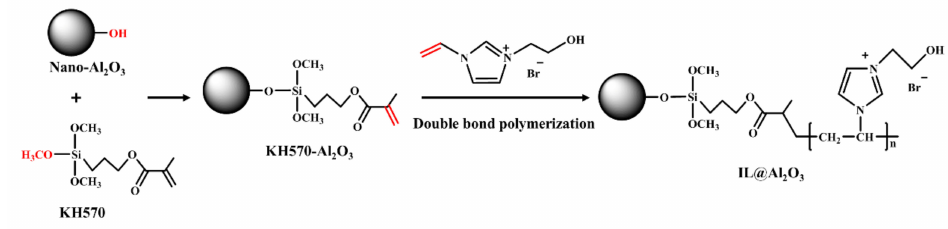
Figure 1. A schematic of the synthesis of IL@Al 2 O 3